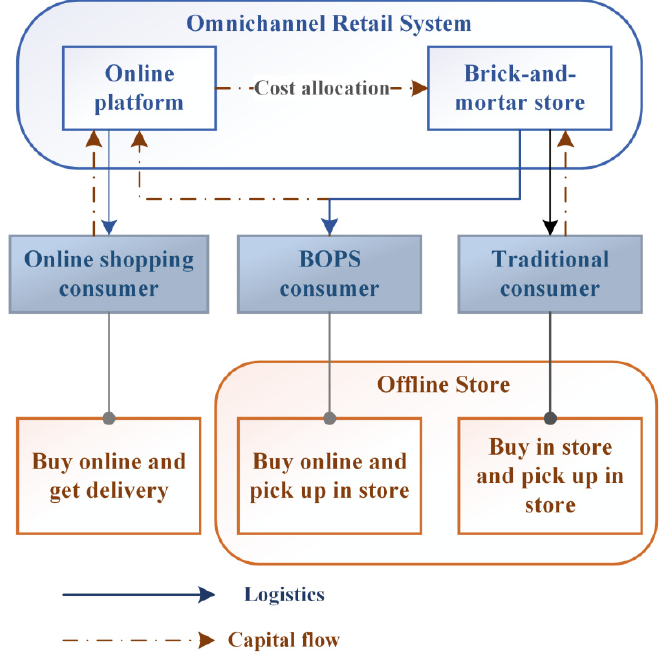
Figure 1. BOPS omnichannel retail model.